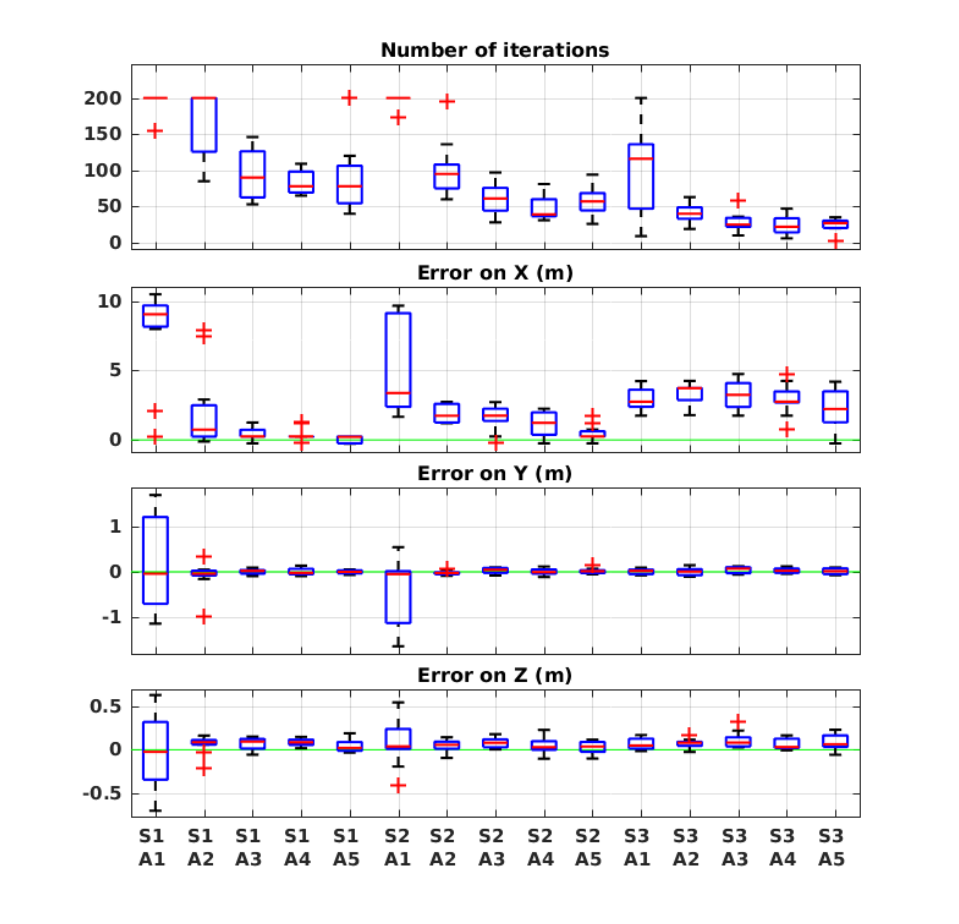
Figure 6. Evaluation results in simulation with different algorithmic parameters in the global framework. See Table 3 for the meaning of the